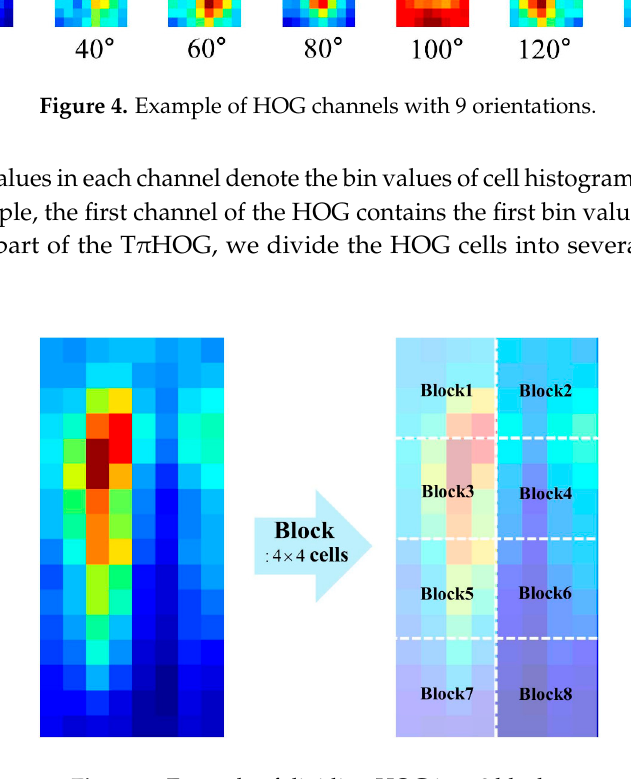
Figure 4. Example of HOG channels with 9 orientations.